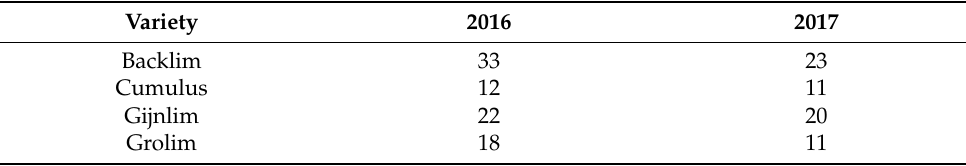
Table 4. Overview of the analyzed samples regarding botanical